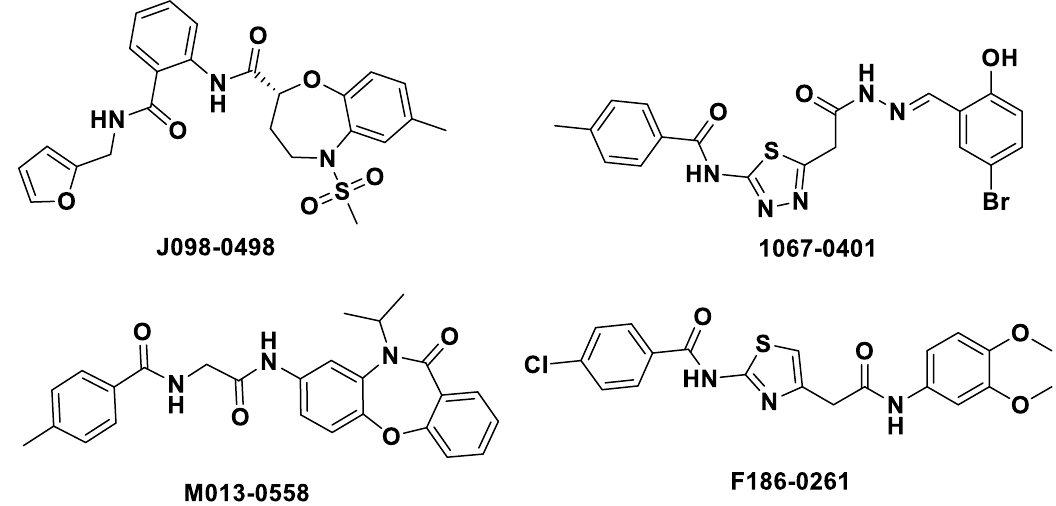
Figure 7. Chemical structures of the potential hit compounds.